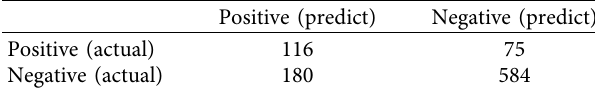
Table 7: High precision data set confusion